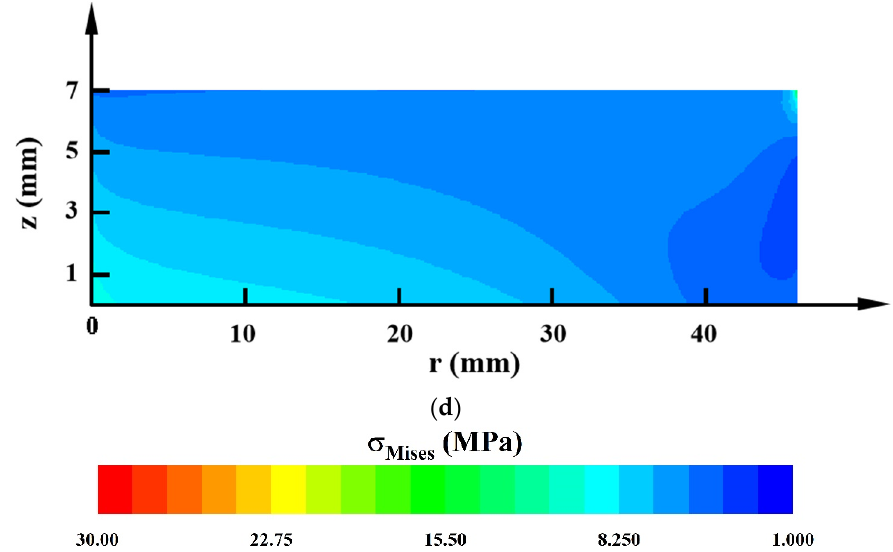
Figure 8. Distributions of thermal stress inside the AlN crystal grown in ( a ) Composite crucible A, ( b ) Composite crucible B, ( c ) Composite crucible C, and ( d ) Composite crucible D.